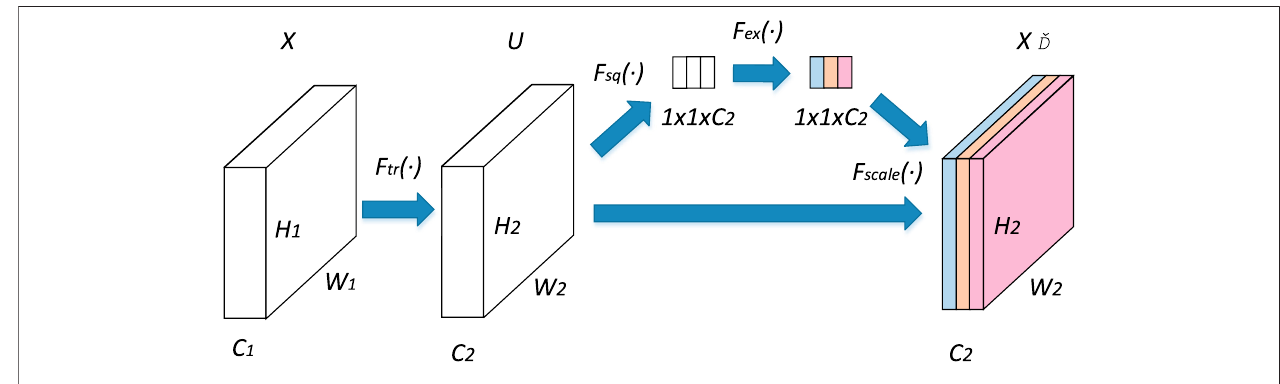
FIGURE 2 | Implementation process of Attention